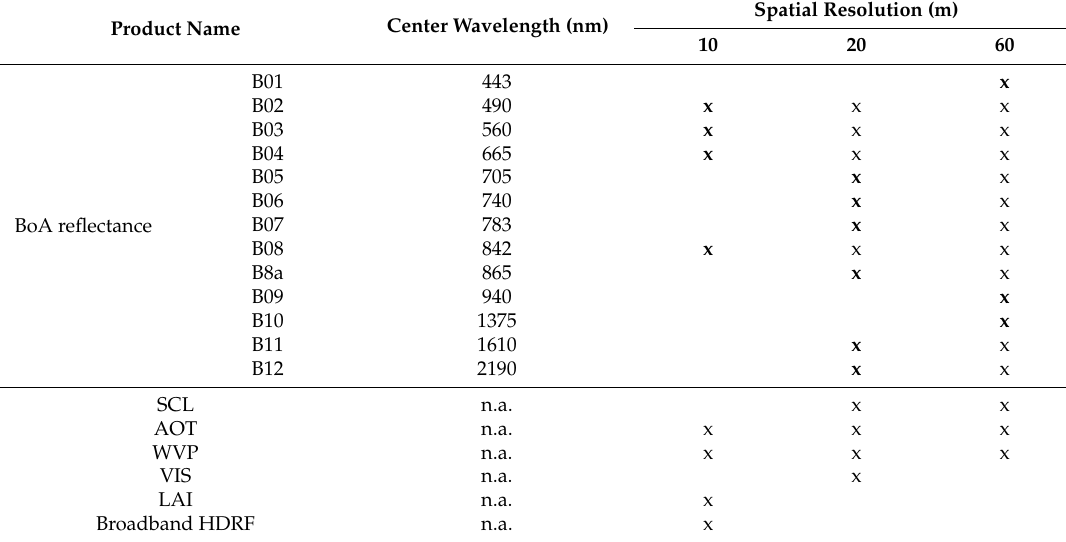
Bold crosses (x) indicate the original spatial resolution. Note that band B10 is not produced at Level-2A.